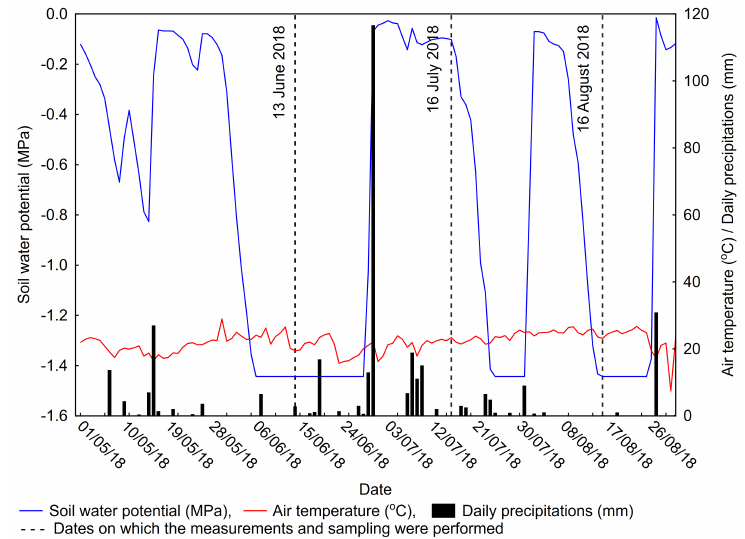
Figure 1. Meteorological data during the period from 1st of May to 31st of August 2018. Dates: 13 June 2018—measurement of the chlorophyll a fluorescence in severe drought period; 16 July 2018—measurement of the chlorophyll a fluorescence in wet period; 16 August 2018—sampling for plant biometric characterisation and leaf anatomical traits